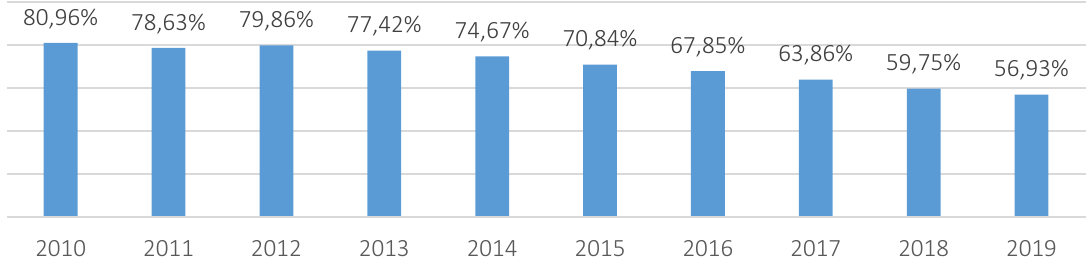
Figure 2. German evolution of national